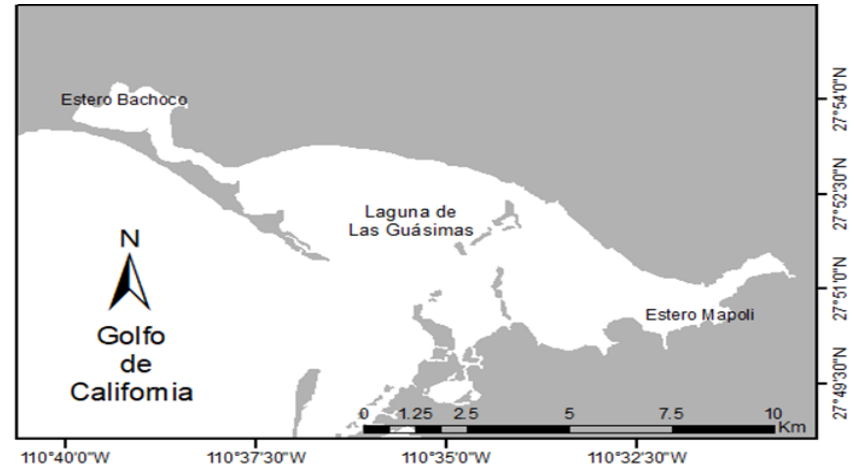
Figure 1. Collecting area, Las Guásimas lagoon, Sonora, Mexico, and central Gulf of California. We performed superficial zooplankton tows (250 microns) every month from 2014 to 2016, inside and outside the lagoon. The samples were preserved in 4% formaldehyde solution (buffered with sodium borate) the samples were inspected and all ephyrae were sorted. All individuals were measured following Straehler-Pohl and Jarms [27], Straehler- Pohl et al. [37], and Holst [28] (Figure 2). Total body diameter (TBD), central disk diameter (CDD), total marginal lappet length (TMLL), lappet stem length (LStL), rhopalial lappet length (RLL), as well as the body proportions, i.e., CDD/TBD × 100, RLL/TMLL × 100, TMLL/TBD × 100, and LStL/TMLL × 100 were calculated (Figure 2).